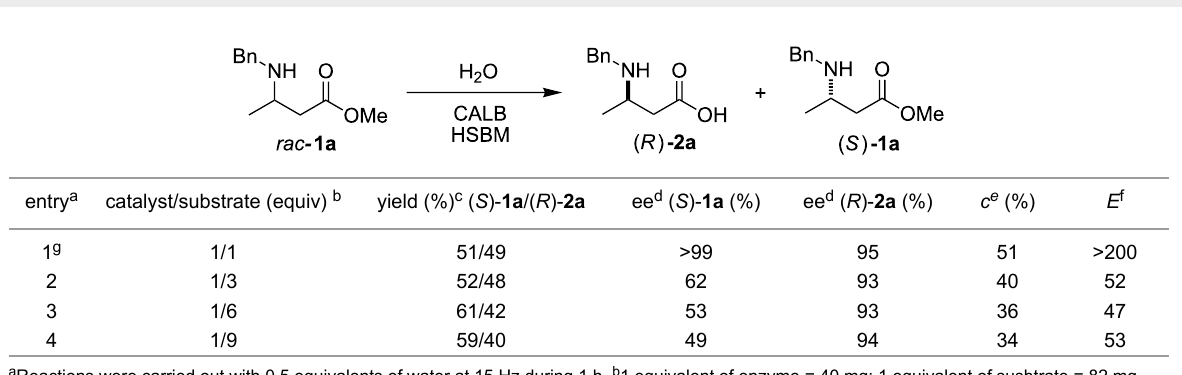
Table 4: Scaling-up of the enzymatic hydrolysis reaction under ball-milling using substrate rac - 1a .